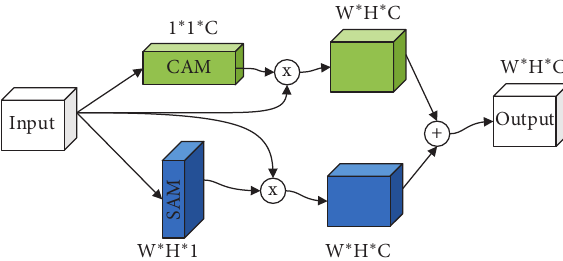
Figure 6: ESA attention